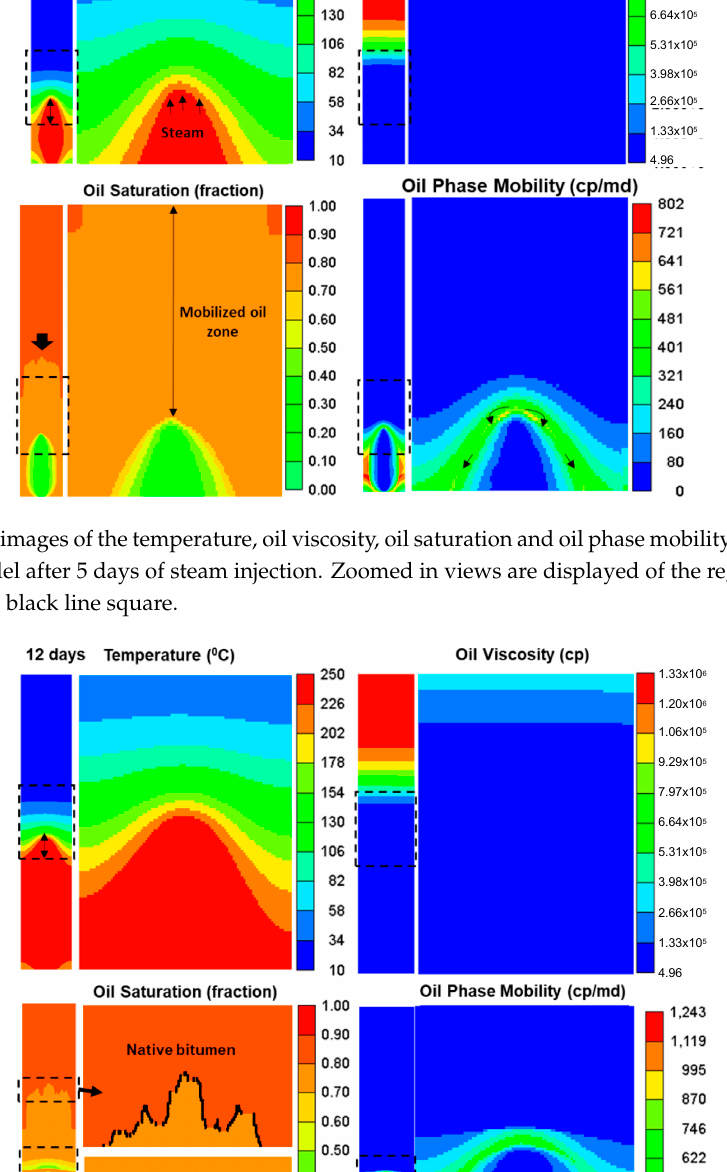
Figure 20. 2D images of the temperature, oil viscosity, oil saturation and oil phase mobility distributions of the VE model after 12 days of steam injection. Zoomed in views are displayed of the region enclosed by the dashed black line square.